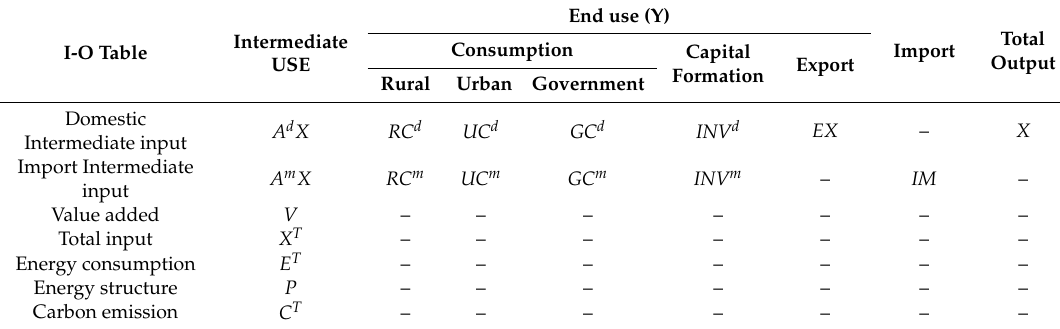
Table 4. A simplified non-competitive Input–output